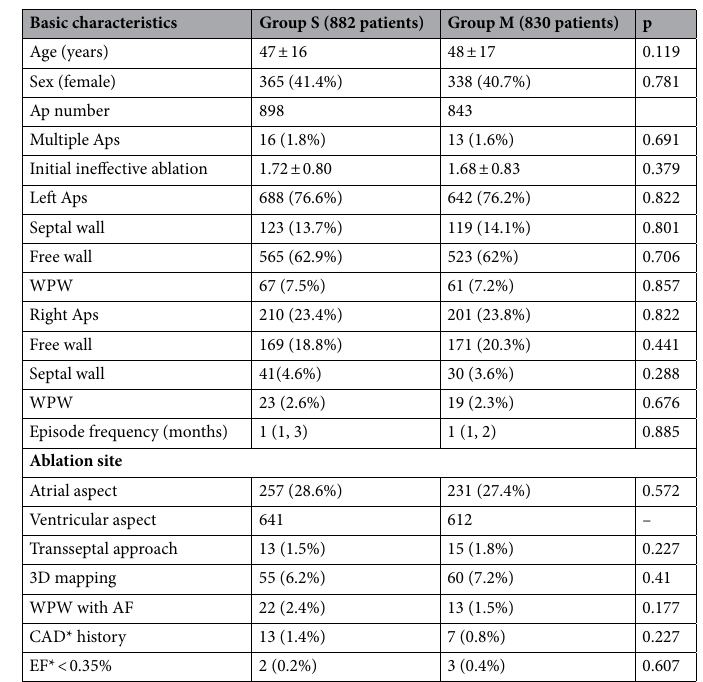
Table 1. Main clinical features of patients stratified by different ablation methods. * EF ejection fraction; CAD coronary artery